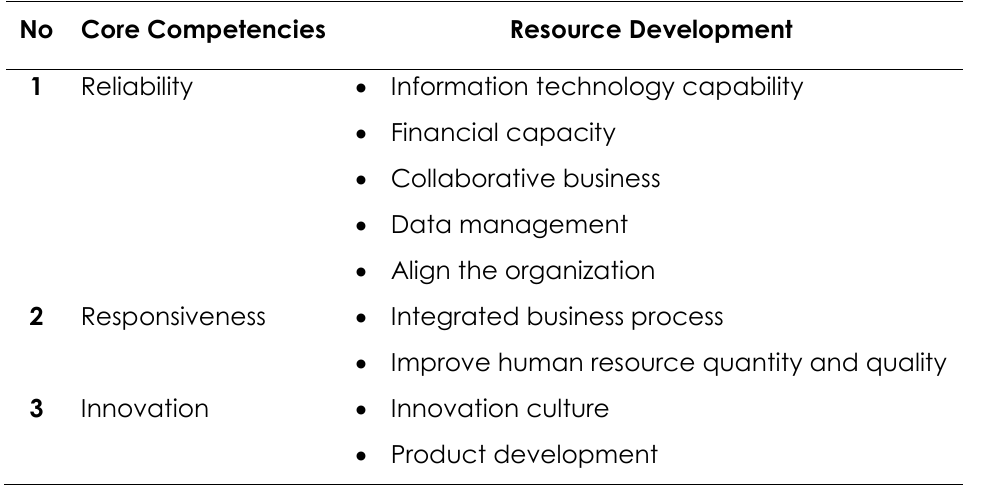
BPJS Ketenagakerjaan Core